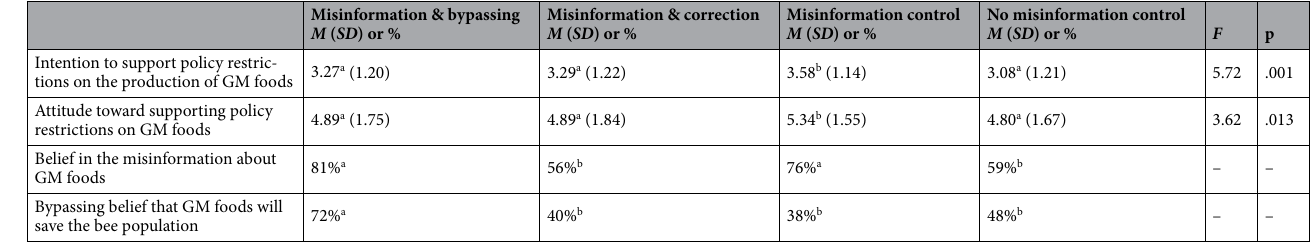
Table 3. Experiment 3 results (preregistered, N = 772). Different superscripts indicate statistically significant pairwise